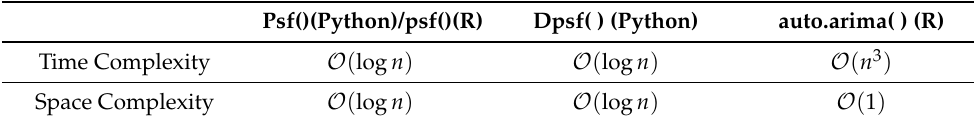
Table 13. Estimated complexities according to the GuessCompx tool [56].